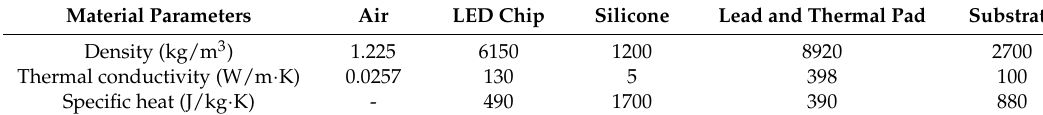
Figure 8. Chemical element analysis result of phosphors in the selected LED with the SEM-EDX. Table 2. Material parameters used in fine element analysis (FEA) modeling.